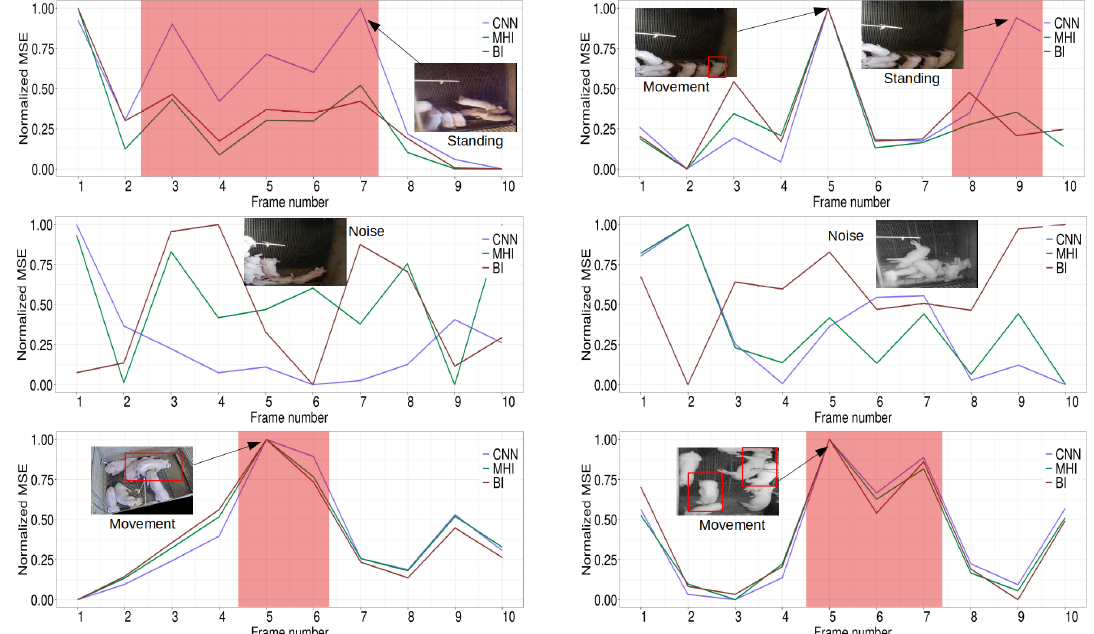
Figure 8. Detection of varying activity levels for six ten-second videos from the pig data set. The first rows shows two figures in which the pigs showed a standing posture. The second row shows two example figures of neglectable noise. The third row shows the detection of regular movement